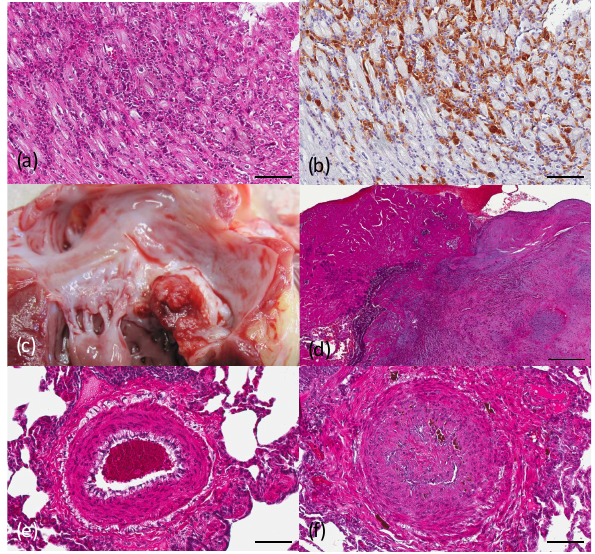
Figure 2. Cardiovascular findings in SIV-infected rhesus macaques ( Macaca mulatta ). (a) Rhesus monkey, no. G5550, infected with SIVmac251, heart. Severe myocarditis with infiltration of lymphohistiocytic cells between muscle fibers. HE stain. Scale bar = 100µm. (b) Rhesus monkey, no. G5550, infected with SIV- mac251, heart. Infiltrating histiocytic cells express SIV antigen. Immunohistochemistry with KK75. Scale bar = 100µm. (c) Rhe- sus monkey, no. G9095, infected with SIVmac251, heart. Verru- cous masses on the mitral valve occluding the lumen. (d) Rhesus monkey, no. G9095, infected with SIVmac251, heart. The verru- cous mass consists of platelets, fibrin, and bacterial colonies. There are fibrotic changes of the myocardium with mild inflammatory cell infiltration. HE stain. Scale bar = 0.5mm. (e) Rhesus mon- key, no. K780, infected with SIVmac251/32H. Medium-sized artery with thickened vessel wall. HE stain. Scale bar = 100µm. (f) Rhe- sus monkey, no. G7685, infected with SIVmac239, lung. Medium- sized artery with thickened vessel wall and occluded lumen with multifocal recanalization. HE stain. Scale bar = 100µm.